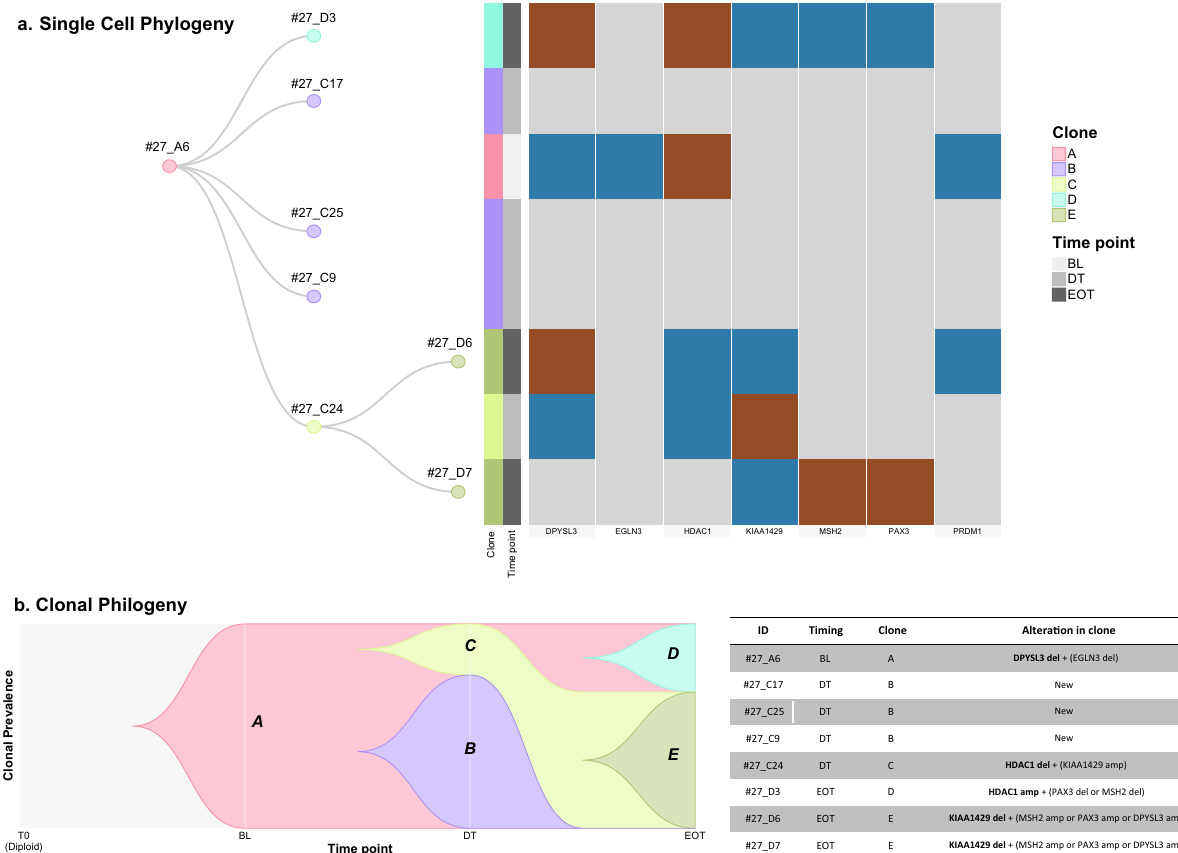
Figure 2. Phylogenetic analysis of patients#27. ( a ) Dendrogram and heatmap show single cell phylogeny obtained from TRONCO. Dendrogram (left) shows single CTCs colored by clones identified by TRONCO while heatmap (right) details the CNA alterations for each CTCs (rows) along the genes (columns) considered for the phylogenetic analysis. Brown and blue colors refer to amplification and deletion, respectively. ( b ) Representation of clonal phylogeny along time. the timescape plot (left) reports on Y-axis the prevalence of each clone while the table (right) describes clonal composition. The column “Alteration in clone” show CNAs defined as “priority” (bold) and “secondary” returned by TRONCO for each clone. The term “new” refers to set of clone with no alterations in genes considered for phylogenetic